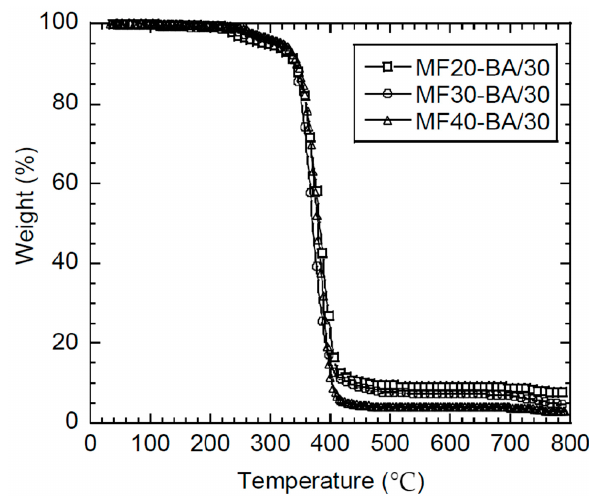
Figure 6. Thermogravimetric analysis of copolymers MF/BA.